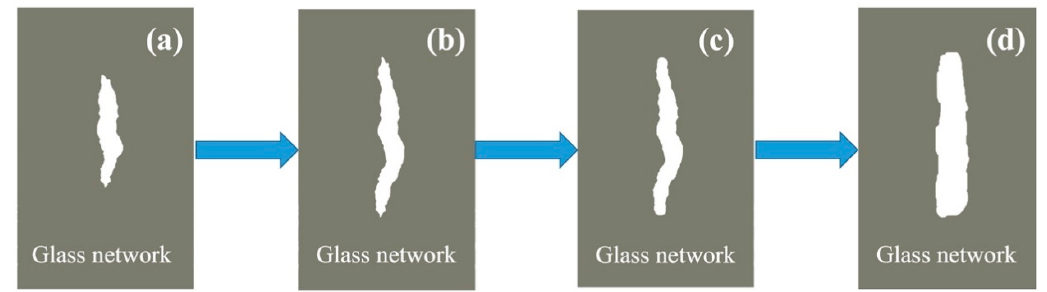
Figure 6. Schematic diagram of the micro-crack blunting mechanism ( a ) pristine; ( b ) microcracks growth; ( c ) tip of microcracks destroyed; ( d ) microcracks blunting.